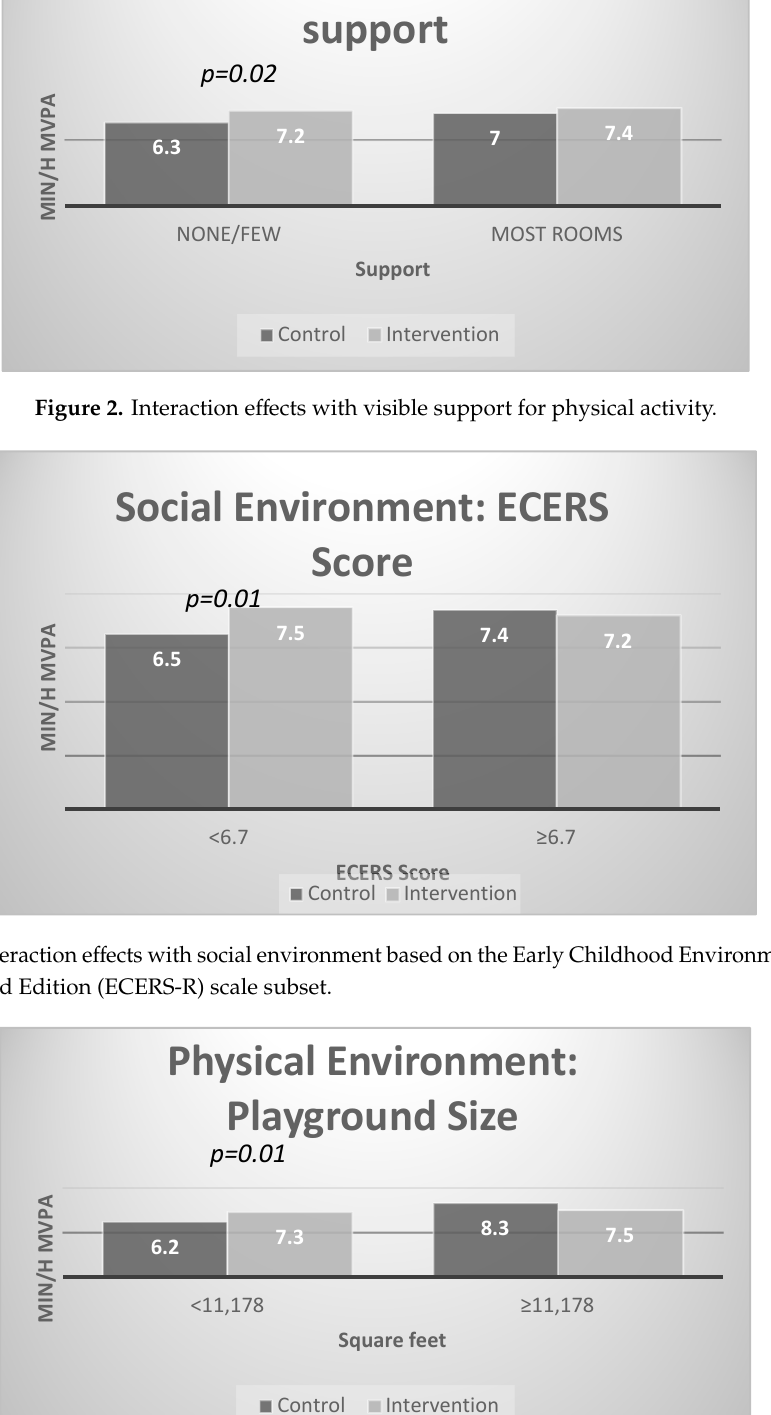
Figure 4. Interaction e ff ects with physical environment: playground size.